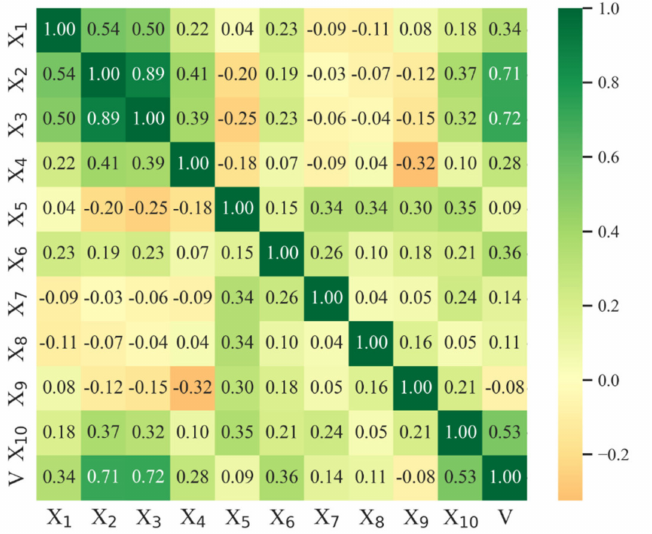
Figure 2. Frequency of input parameters and observed failure modes of database.